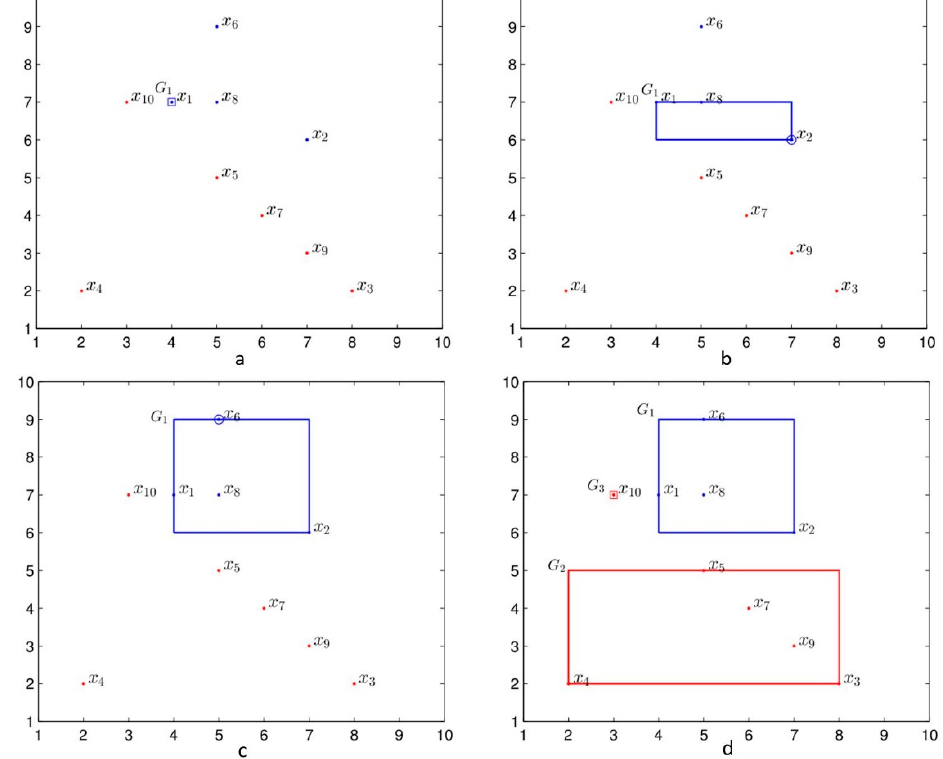
Figure 3. The example of Algorithm 1. ( a ) The hyperbox granule by x 1 ., ( b ) the join hyperbox granule between the granule G 1 and the atomic hyperbox granule [7 6 7 6], ( c ) the join hyperbox granule between G 1 and the atomic hyperbox granule [5 9 5 9], and ( d ) the granule set including three hyperbox granules with class label 1 (blue) and class label 2 (red).